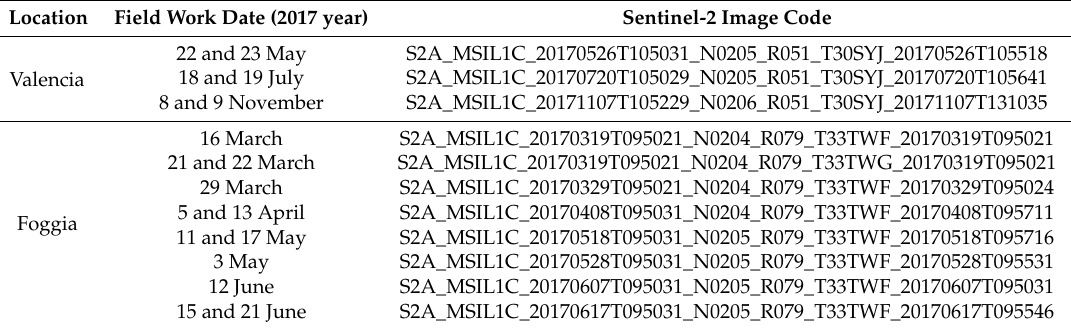
Table 2. Sentinel-2 images used in each field